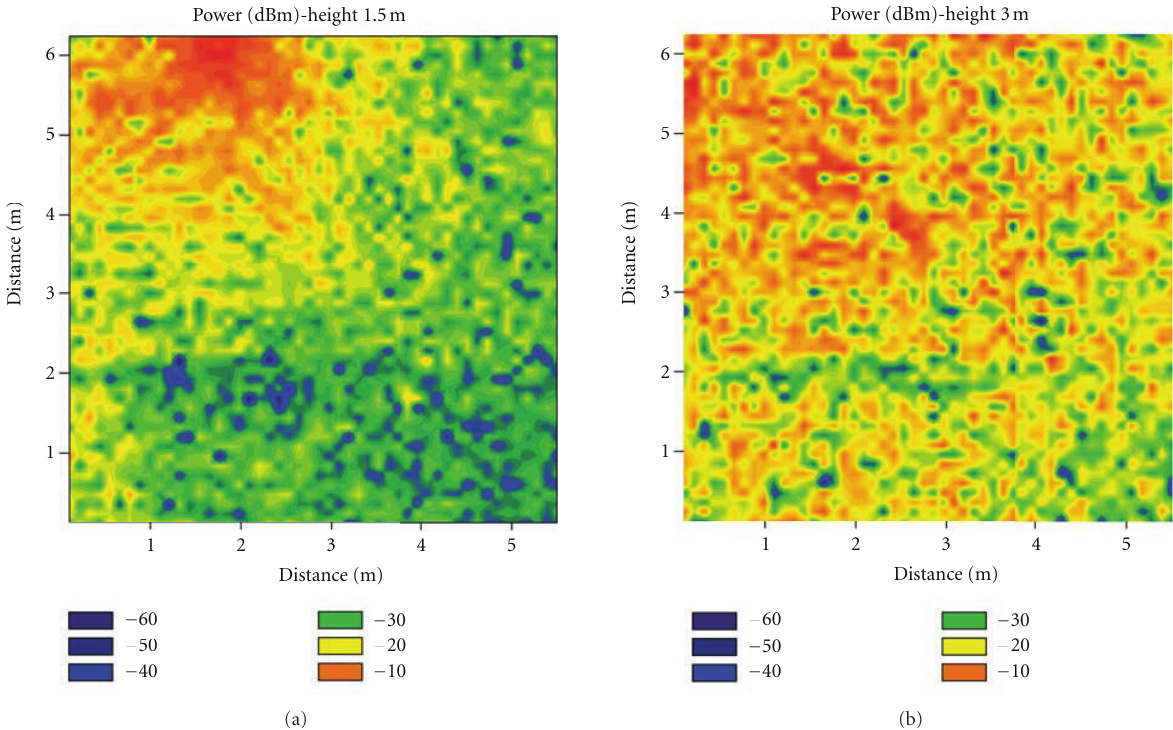
Figure 10: Spatial distribution of received power (dBm) for di ff erent heights in the indoor scenario of Figure 2(a) obtained by means of 3D ray launching